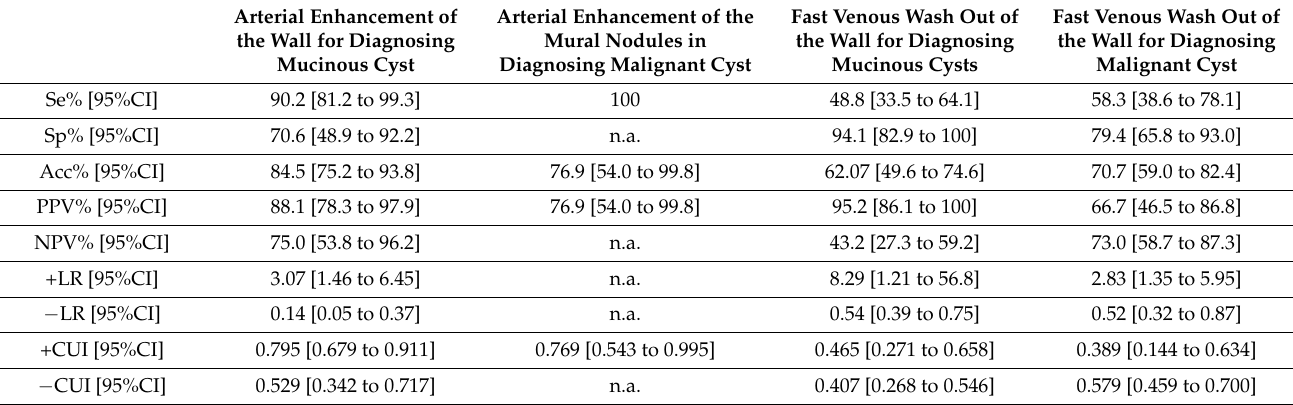
Table 3. CH-EUS performances as a diagnosis